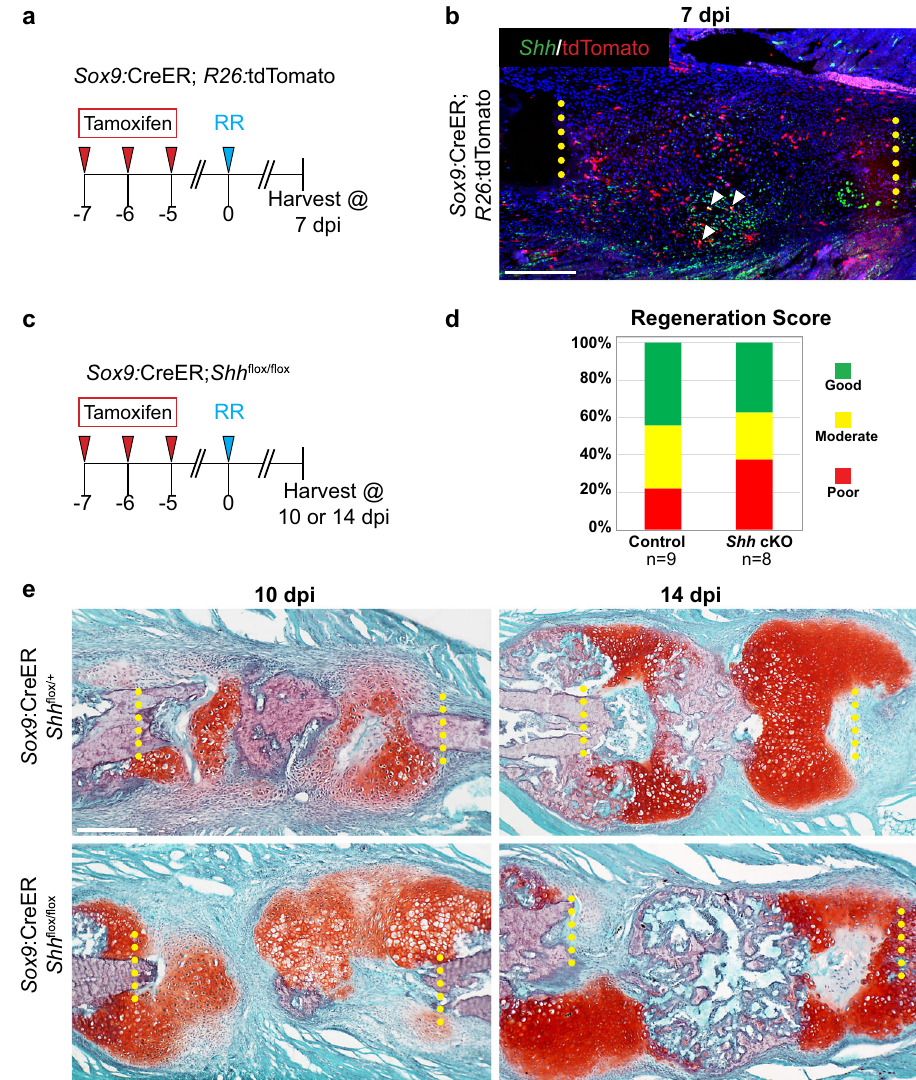
Fig. 5 The primary source of SHH is not Sox9 -derived SSPCs. a Experimental overview. To lineage-trace Sox9 + lineage cells, Sox9: CreER ;R26: tdTomato animals received tamoxifen injections on days − 7, − 6, and − 5. All rib resections were performed on day 0 and tissue was harvested at 7 dpi to assay Shh expression in b . b RNA-ISH for Shh (green) on histological sections at 7 dpi. Sox9 + lineage cells express tdTomato (tdT, red). Shh expression is strongly detected within cells located in the central resection gap and in the surrounding periosteal tissues. Although a few tdT + lineage-traced cells express Shh (white arrowheads), the majority of Shh -expressing cells are tdT-negative. Surgical cut sites are indicated with yellow dotted lines. N = 3. Scale bar = 200 microns. c Experimental overview. To knock out Shh in Sox9 + lineage cells, Sox9: CreER ;Shh fl ox/ fl ox animals received tamoxifen injections on days − 7, − 6, and − 5. All rib resections were performed on day 0 and tissue was harvested at 10 or 14 dpi to assay regeneration outcomes. d Blinded scoring of regeneration outcomes. Histological sections were used to score regeneration outcomes as Good, Moderate, or Poor (see Methods for details regarding scoring criteria). Control animals largely healed well and scored as Good (4/9 animals) or Moderate (3/9 animals). Similarly, Sox9: CreER ;Shh fl ox/ fl ox animals largely healed well (3/8 animals) or Moderate (2/8). Animals from 10 and 14 dpi were pooled for graphical representation. e At 10 dpi, Sox9: CreER ;Shh fl ox/ + controls and Sox9: CreER ;Shh fl ox/ fl ox mice both generate a large Safranin-O stained callus composed largely of cells with chondrocyte morphology and with the central-most portion beginning osteogenic differentiation. At 14 dpi, Sox9: CreER ;Shh fl ox/ + controls and Sox9: CreER ;Shh fl ox/ fl ox mice have large Safranin-O-stained calluses with a central region undergoing bone conversion. Surgical cut sites are indicated with yellow dotted lines. Scale bar = 200